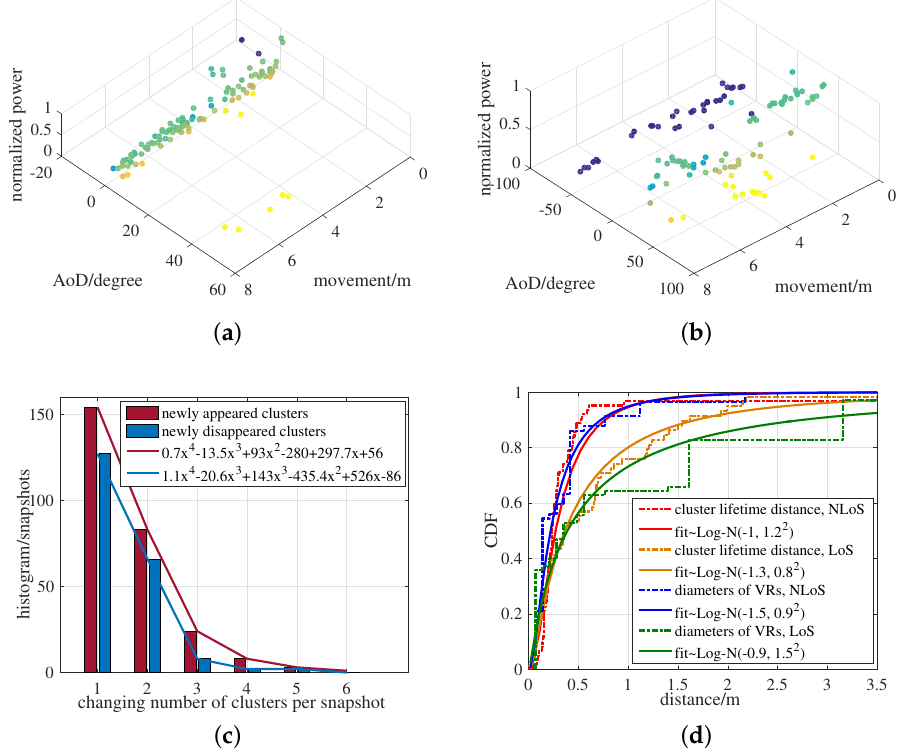
Figure 5. Clustering and tracking profiles of measurement clusters. ( a ) Cluster-tracking profiles in LoS condition. ( b ) Cluster-tracking profiles in NLoS condition. ( c ) Birth and death histogram of clusters per snapshot. ( d ) cumulative density functions (CDF) of cluster lifetime distances